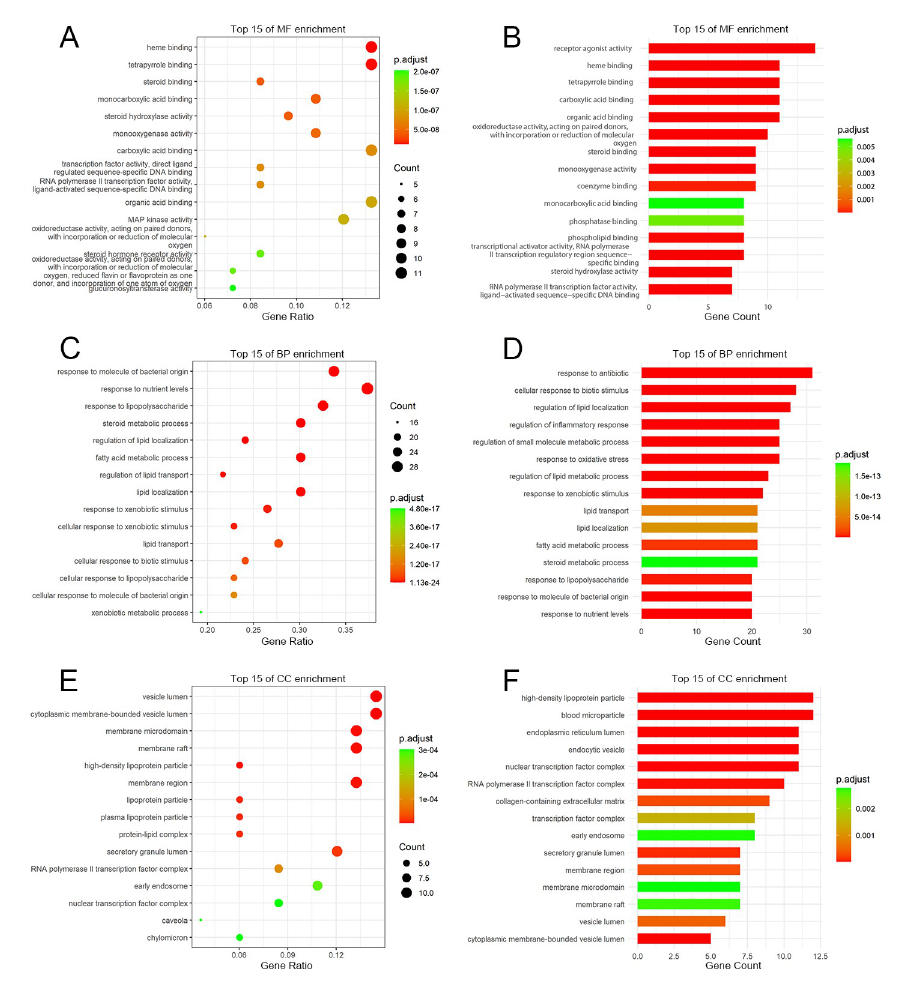
Fig 3. Gene Ontology (GO) enrichment analysis for 83 potential targets of SHCZF against cholestasis. (A, B) The bubble chart and histogram of top 15 molecular function (MF) enrichment. (C, D) The bubble chart and histogram of top 15 biological process (BP) enrichment. (E, F) The bubble chart and histogram of top 15 cellular component (CC) enrichment.